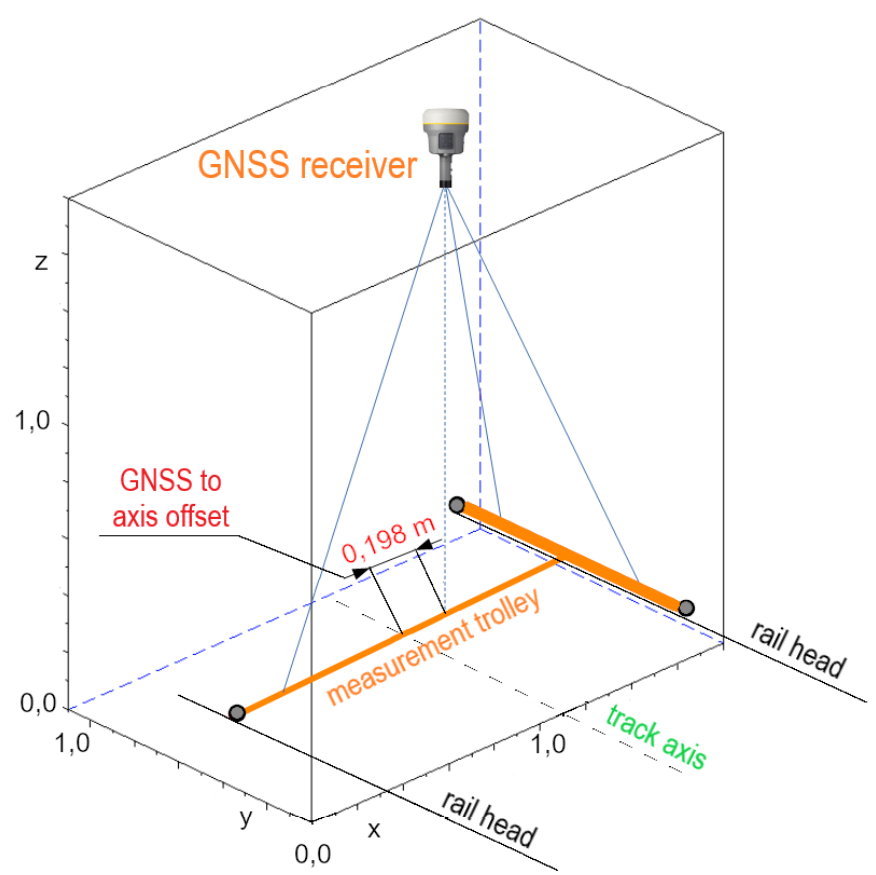
Figure 7. Spatial model of the measuring set in the local system of xyz coordinates.